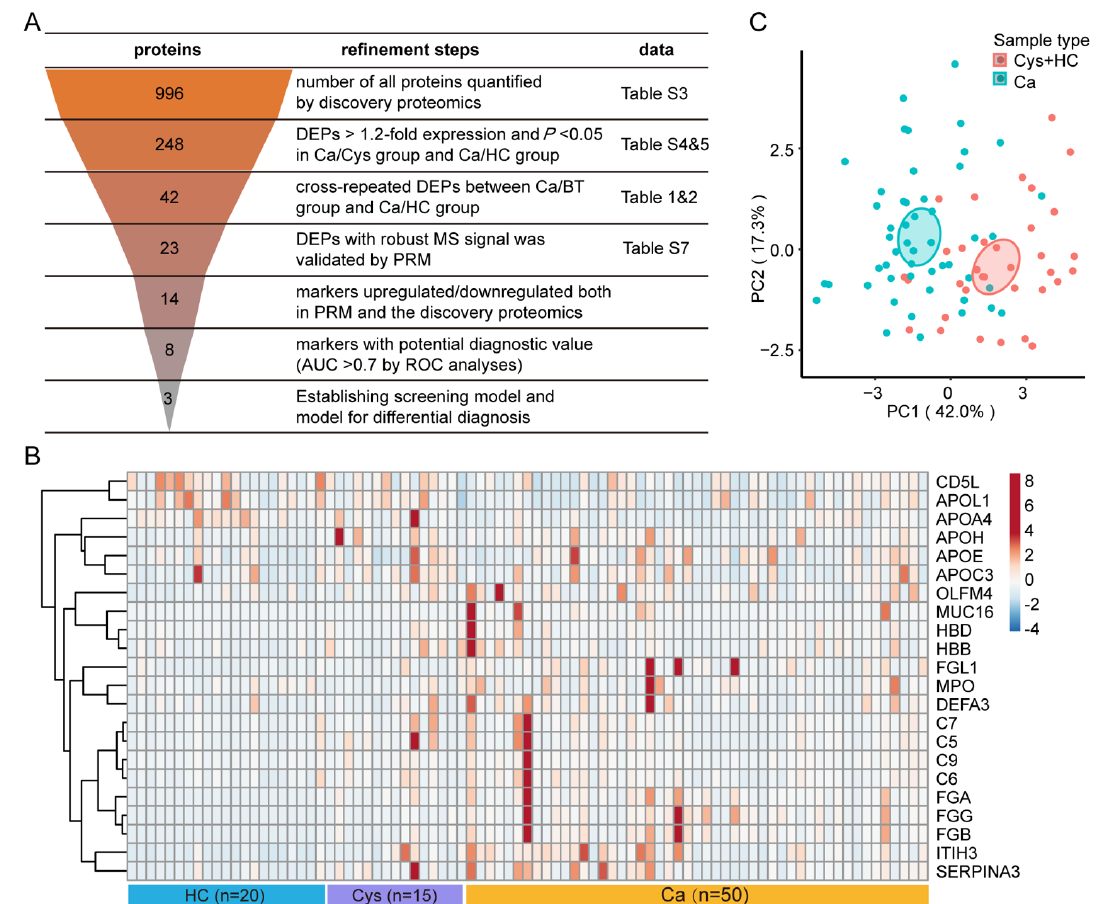
Figure 5. Biomarkers validation by targeted proteomics. ( A ) The funnel diagram illustrates the main processes of narrowing the potential candidates and, finally, establishing a diagnostic model. The orange funnel ‐ shaped picture in the left column represents the process of step ‐ by ‐ step screening of protein candidates, and the numbers inside represent the number of proteins in each step. The mid ‐ dle column represents the performed screening conditions, and the right column represents the cor ‐ responding data tables. ( B ) Heatmap of relative abundance of 14 candidate proteins using PRM approach. Colored red represents an increasing trend, colored blue represents a decreasing trend,